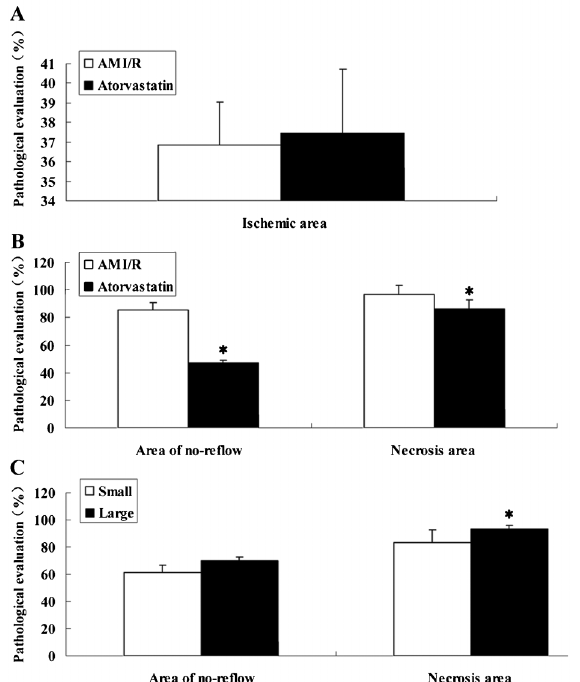
Figure 1. A , Comparison of ischemic area (ligation area) between two groups. B , Comparison of area of no-reflow and necrosis area between two groups. C , Comparison of area of no-reflow and necrosis area between small and large groups. AMI/R: acute myocardial infarction and reperfusion. *P , 0.01, compared to AMI/R or small groups (one-way ANOVA followed by the Student-Newman-Keuls test and the Student t